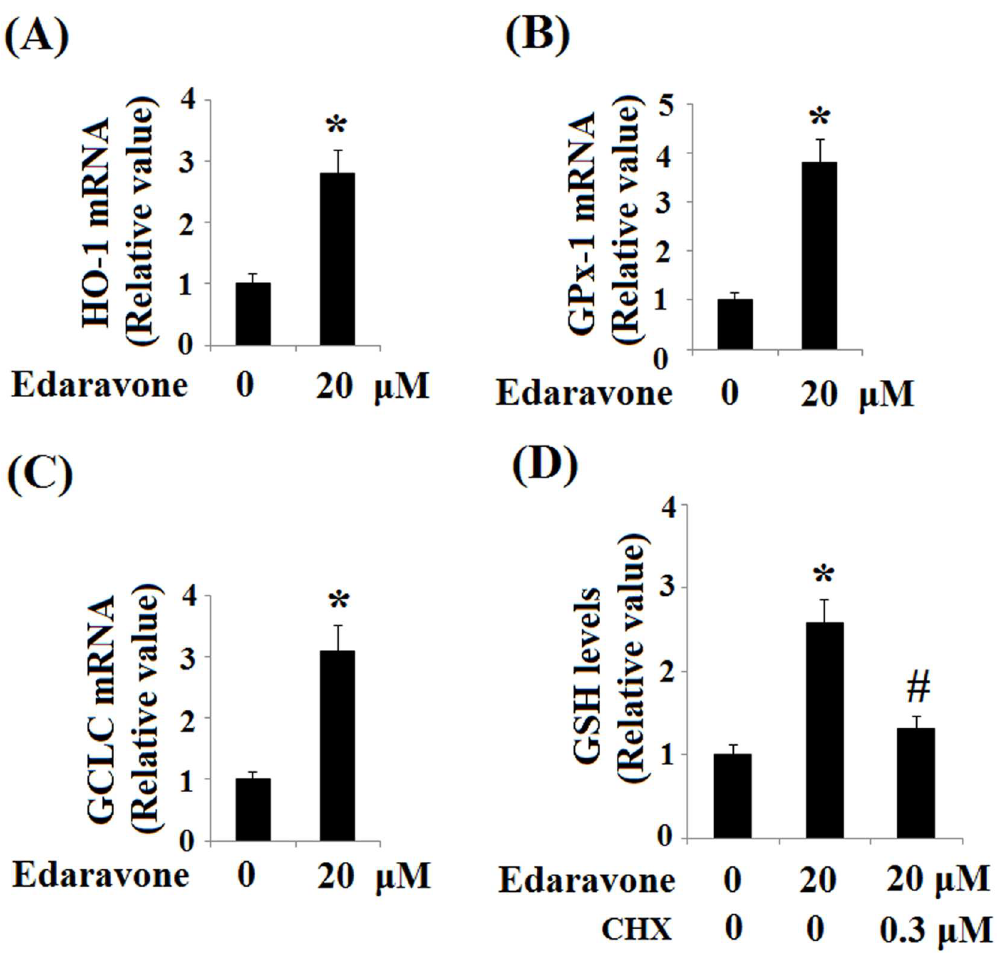
Fig 9. Effects of edaravone on Nrf2 target gene expression in primary HCEpiCs. Cells were treated with edaravone for 24 h. Gene expressionwas determinedby real-time PCR analysis. (A) HO-1 mRNA; (B) GPx-1 mRNA; (C) GCLC mRNA; (D) GSH levels (ANOVA: * , P < 0.001vs. non-treatment control; #, P < 0.001vs. 450 mOsM treated